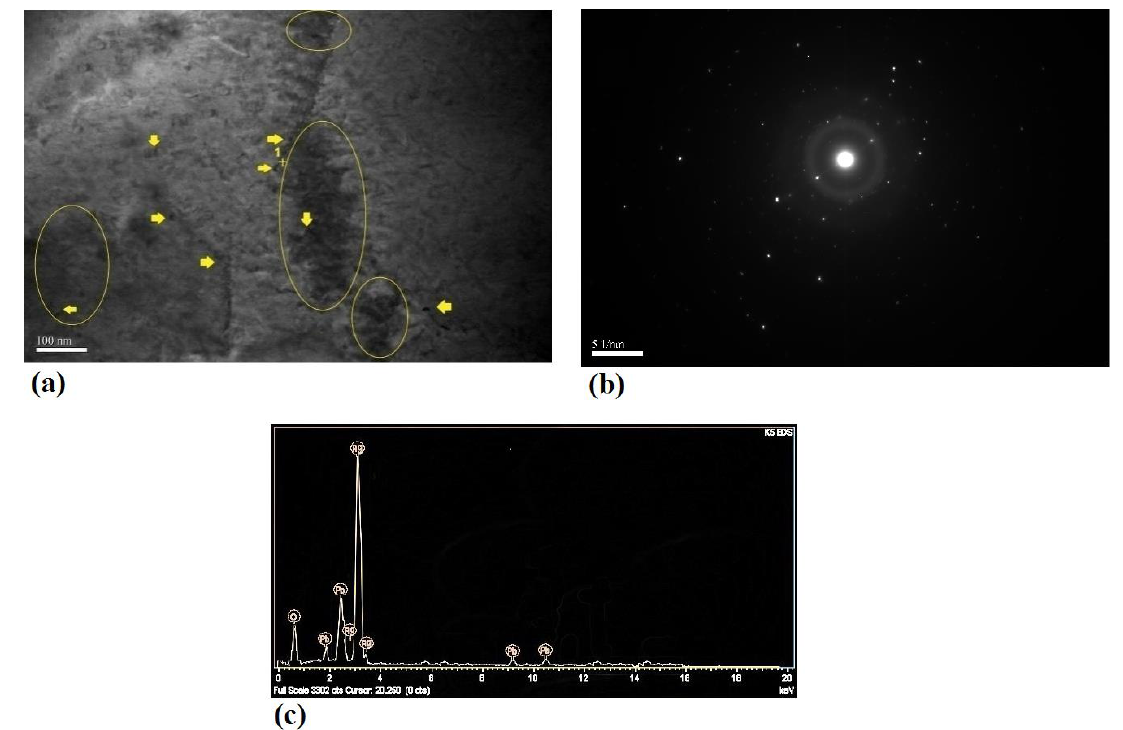
Figure 5. ( a ) Bright field image, ( b ) SAD pattern, and ( c ) EDS result of Pb – 0.5%Ag – 10pass.